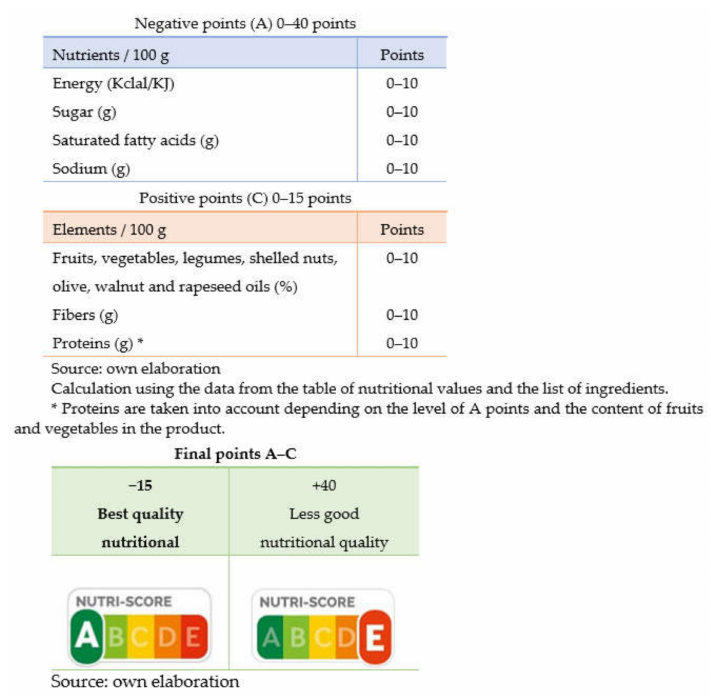
Figure 2. Nutri-Score algorithm